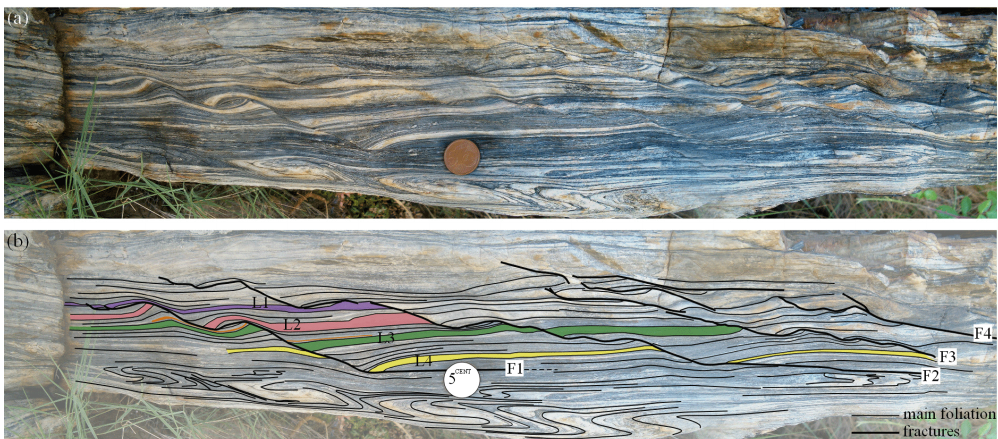
Figure 1. Examples of brittle deformation localisation in a ductile dominant system. (a) small-scale shear fractures (F1 to F4) with flat/ramp segments and roll-over geometries in deformed banded quartzites of the Rabassers outcrop, at Cap de Creus (E Pyrenees, Spain) (Gomez- Rivas et al., 2007); (b) the interpreted structures. Fracture planes are smooth. Antithetic, synthetic and double-sense drag folds can be observed. Note that same layers at both sides of fractures do not present the same drag fold pattern. Displacements along fault surfaces are not constant and do not show an elliptical distribution, as expected for an isolated fracture. Maximum displacement–length relationships ( d max /L) range between 0.10 and 0.15. These fractures are interpreted as formed by segment linkage and growth during coetaneous brittle and ductile deformation. Fracture offsets of reference layers are 0cm (L1), 3.5–3.8cm (L2), 2.5–3.0cm (L3) and 3.3–3.7cm (L4). This view is perpendicular to the foliation and fracture planes. Anisotropy of this rock is a consequence of grain size differences between dark and white layers and preferred orientation of phyllosilicates. The diameter of the Eur 0.05 coin is